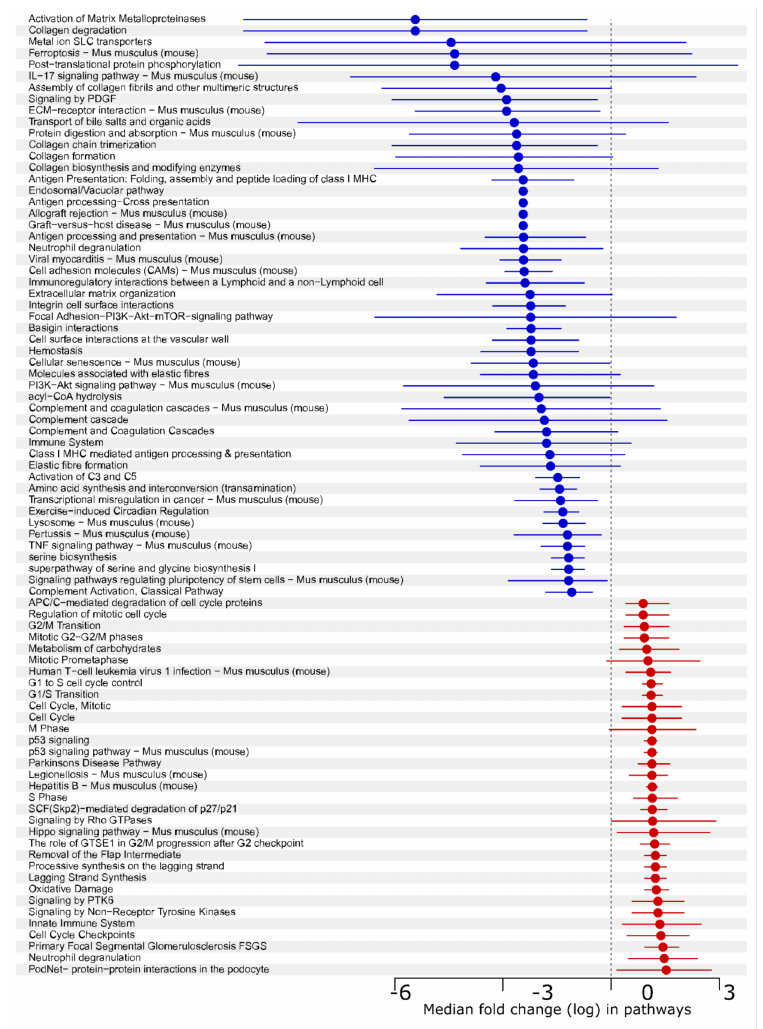
Figure 7. The gene set enrichment analysis of JUN-sarcoma cell lines. Median log (fold change) with 95% confidence interval in pathways sorted by fold change. Downregulated pathways are shown in blue, whereas upregulated pathways are shown in red colours. Analysis revealed that the downregulated genes are dominated by extracellular matrix and cell adhesion, as well as antigen presentation, whereas among upregulated pathways, those related to cell cycle regulation and DNA replication are particularly frequent (see Table S7 The gene set enrichment analysis for complete list of genes in each